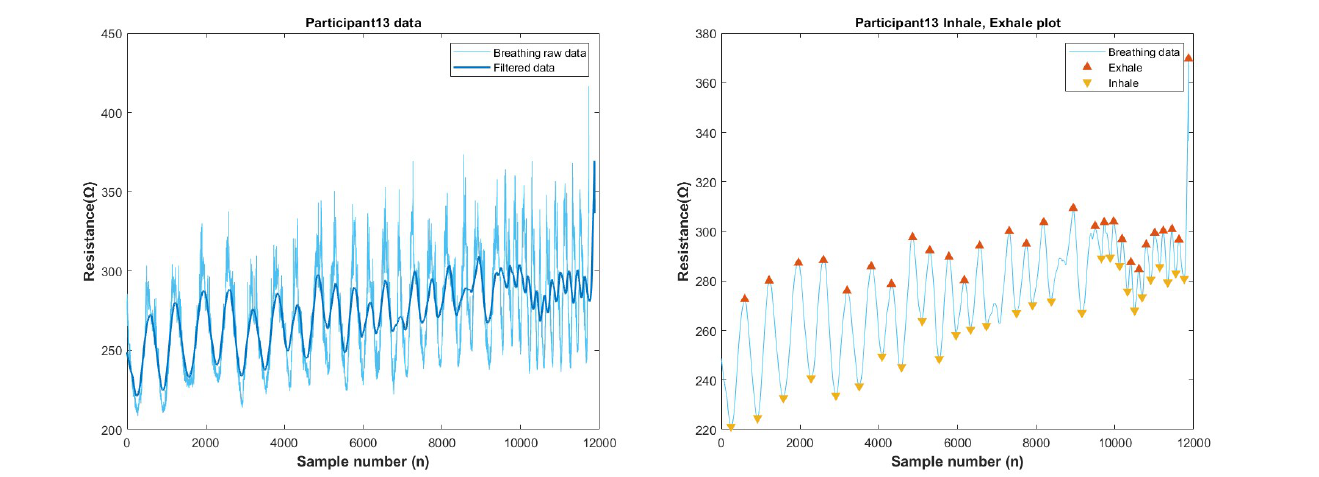
Figure A28. Breathing Test data of Participant